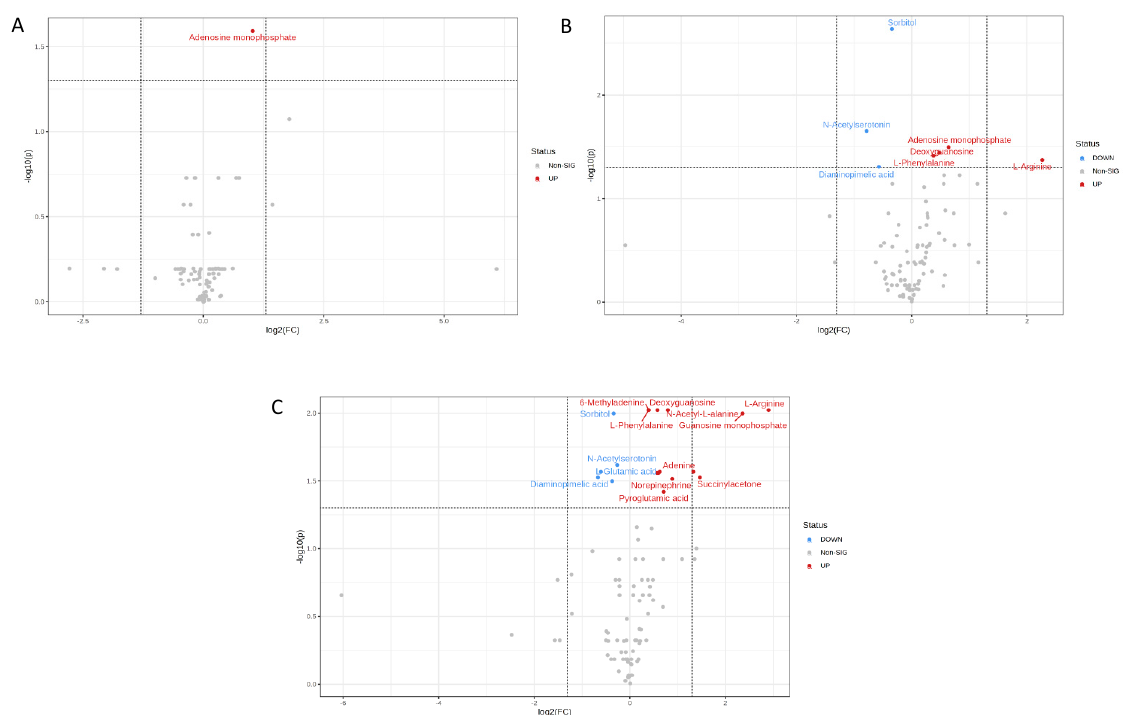
Figure 4. Volcano plots of U373 cells treated with ( A ) paclitaxel 4.2 nM and DMSO; ( B ) DMSO with etoposide 10 µg/mL; ( C ) DMSO with (paclitaxel 4.2 nM + etoposide 10 µg/mL). Table 3. Statistically significant metabolites in U373 cells treated with paclitaxel 4.2 nM and/or etoposide 10 µg/mL.